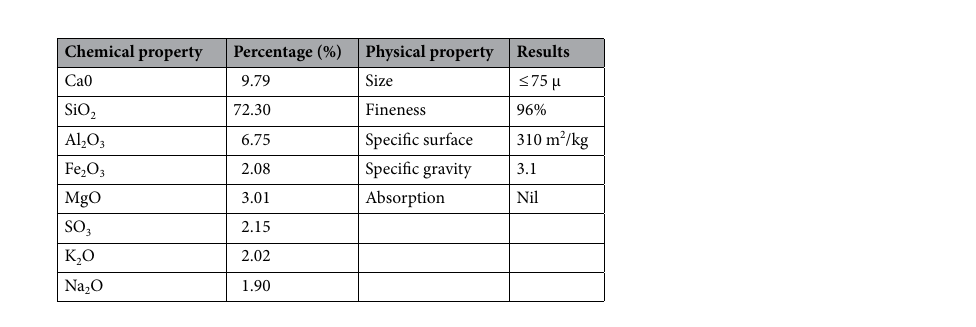
Table 2. Physical and chemical property of glass.